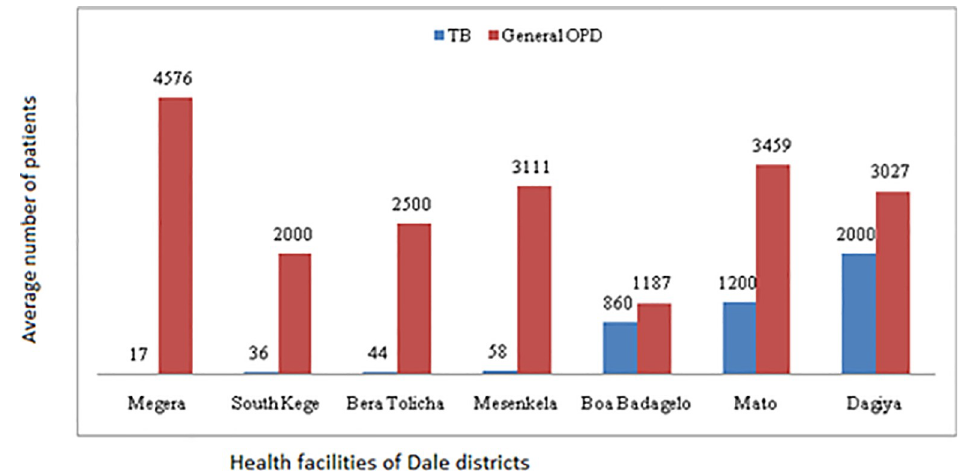
Fig 1. Total OPD patients and TB suspected patients per year in the Dale district health facilities, Sidama Zone, Southern Ethiopia.